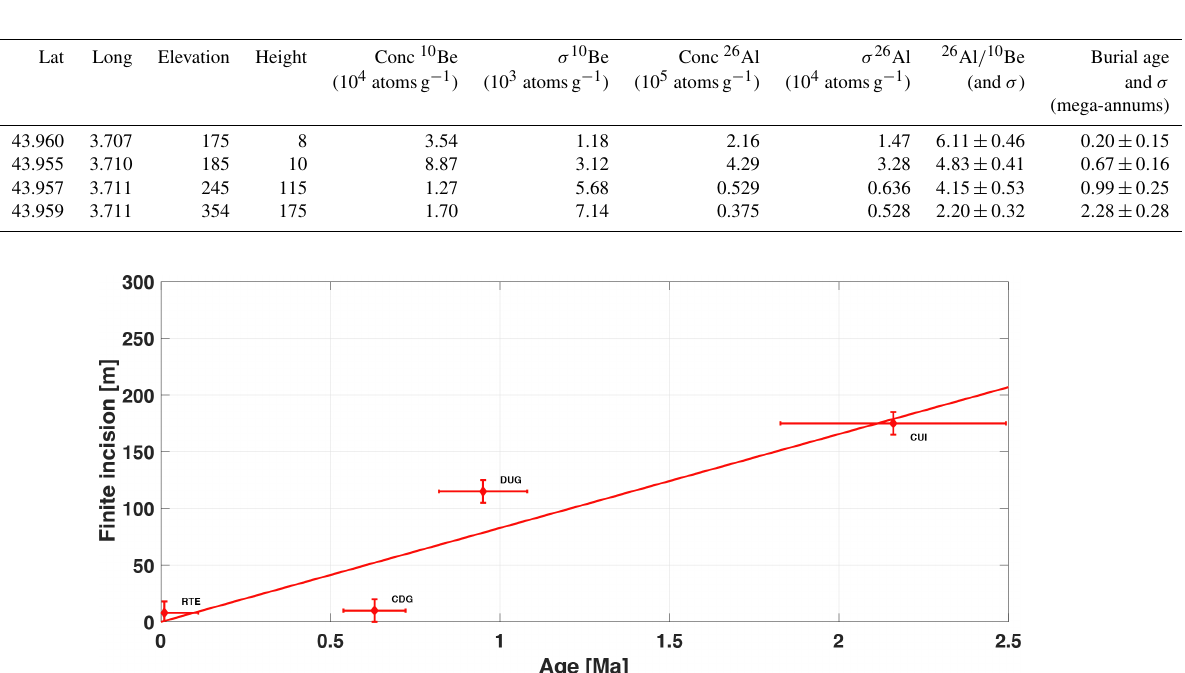
Table 1. Samples analytical results and parameters. Cave abbreviations are RTE for the Route Cave, CDG for the Camp de Guerre Cave, DUG for the Dugou Cave and CUI for the Cuillère Cave. Main parameters are the geographical coordinate (lat and long in decimal degrees), the elevation (a.s.l.), and the height (a.b.l., computed relatively to the surface river elevation). The concentration (atomsg − 1 quartz) of 10 Be and 26 Al in collected sand samples are all AMS 10 Be / Be and 26 Al / Al isotopic ratios, corrected for full procedural chemistry blanks and normalized to KN − 5–4 and KN − 4–2, respectively. The error in the parenthesis is for total analytical error in final average 10 Be and 26 Al concentrations based on statistical counting errors in final 10 Be / Be ( 26 Al / Al) ratios measured by AMS in quadrature, with a 1% error in 9 Be spike concentration (or a 4% error in 27 Al assay in quartz) and a 2% (or 3%) reproducibility error based on repeat of AMS standards. Burial age (minimum) assuming no post-burial production by muons at given depth (all deeper than 30m) in cave below surface and assuming initial 26 Al / 10 Be ratio is given by the production ratio of 6.75. The burial age error determined by using a ± 1 σ range in the measured 26 Al / 10 Be ratio.